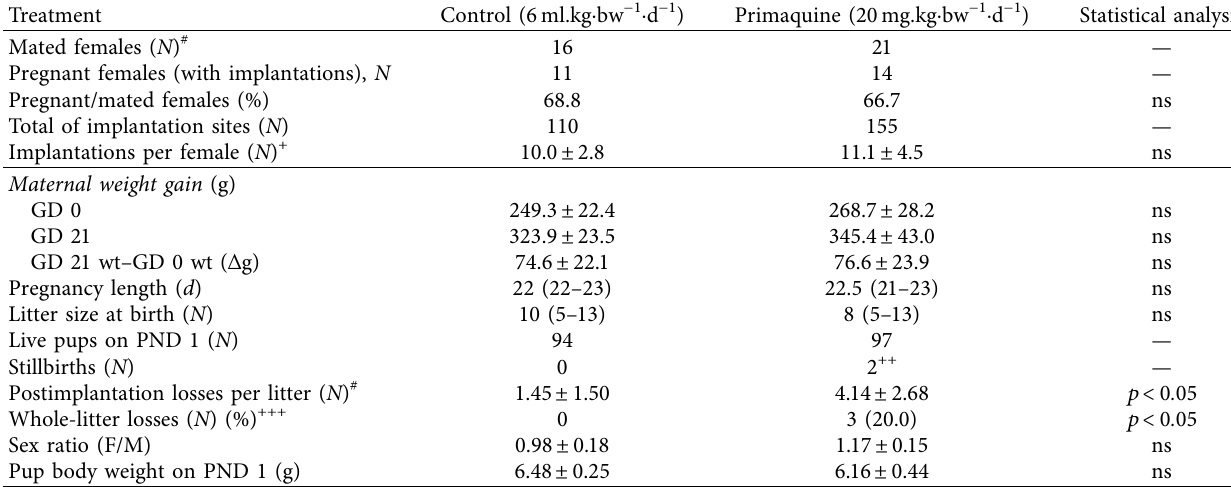
Table 2: Effects of primaquine administered orally to rats during pregnancy (GD 0–21) on maternal and offspring variables evaluated at